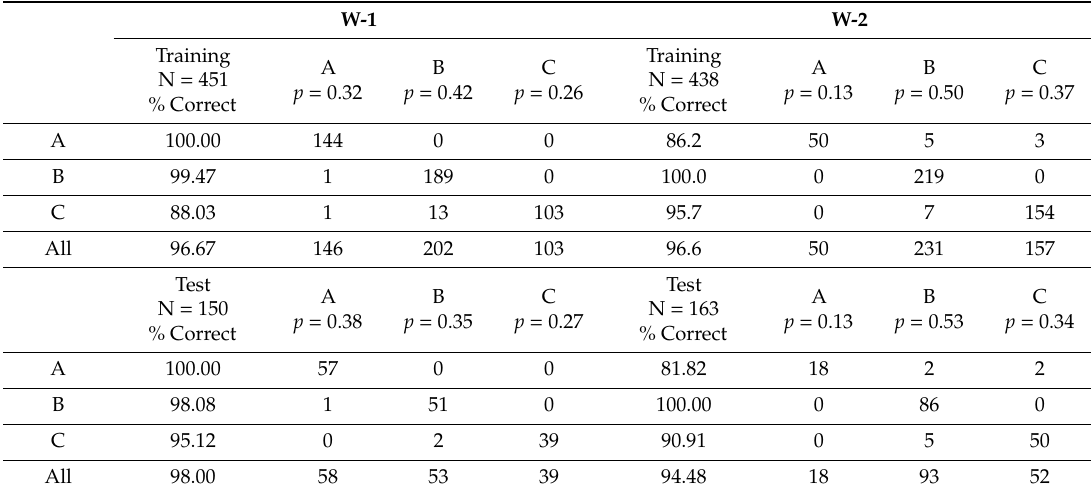
Table 3. Classification matrix, based on the discriminant function, W-1 and W-2